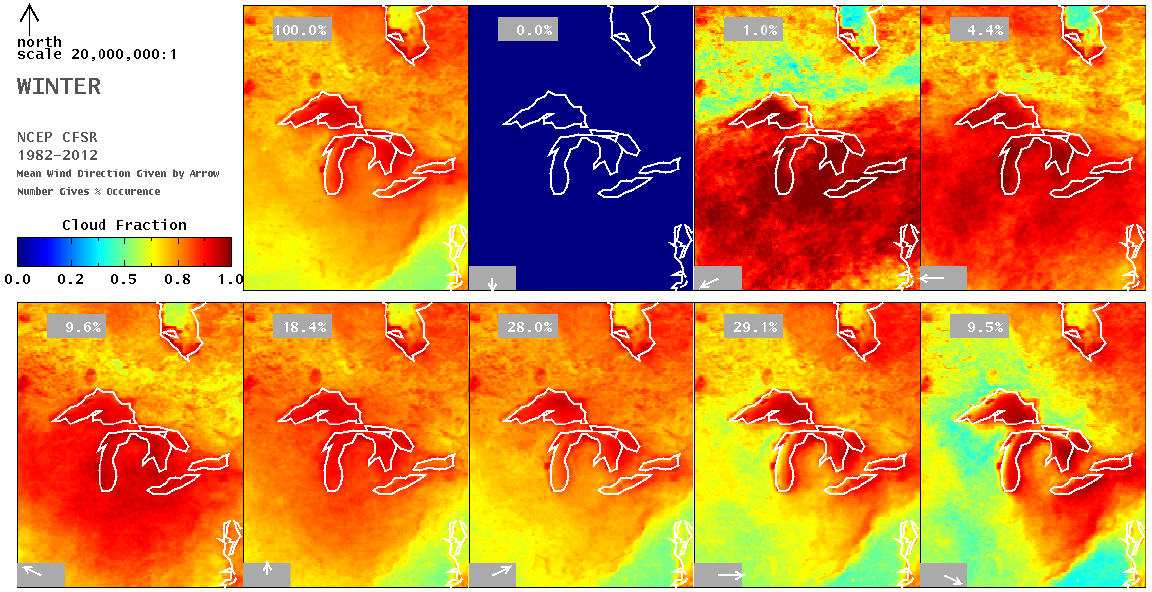
Figure 9. PATMOS-x cloud cover for the region during the 31-year time period during the winter months (December, January and February) composited with respect to wind direction. Same as Figure 7 except for winter.